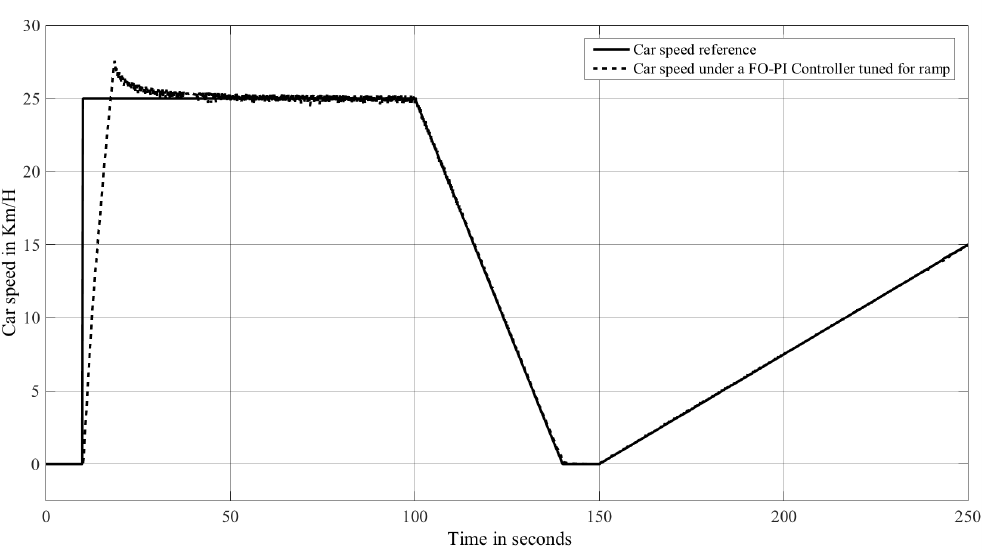
Figure 16. Car speed with the system under a Fractional Order PI